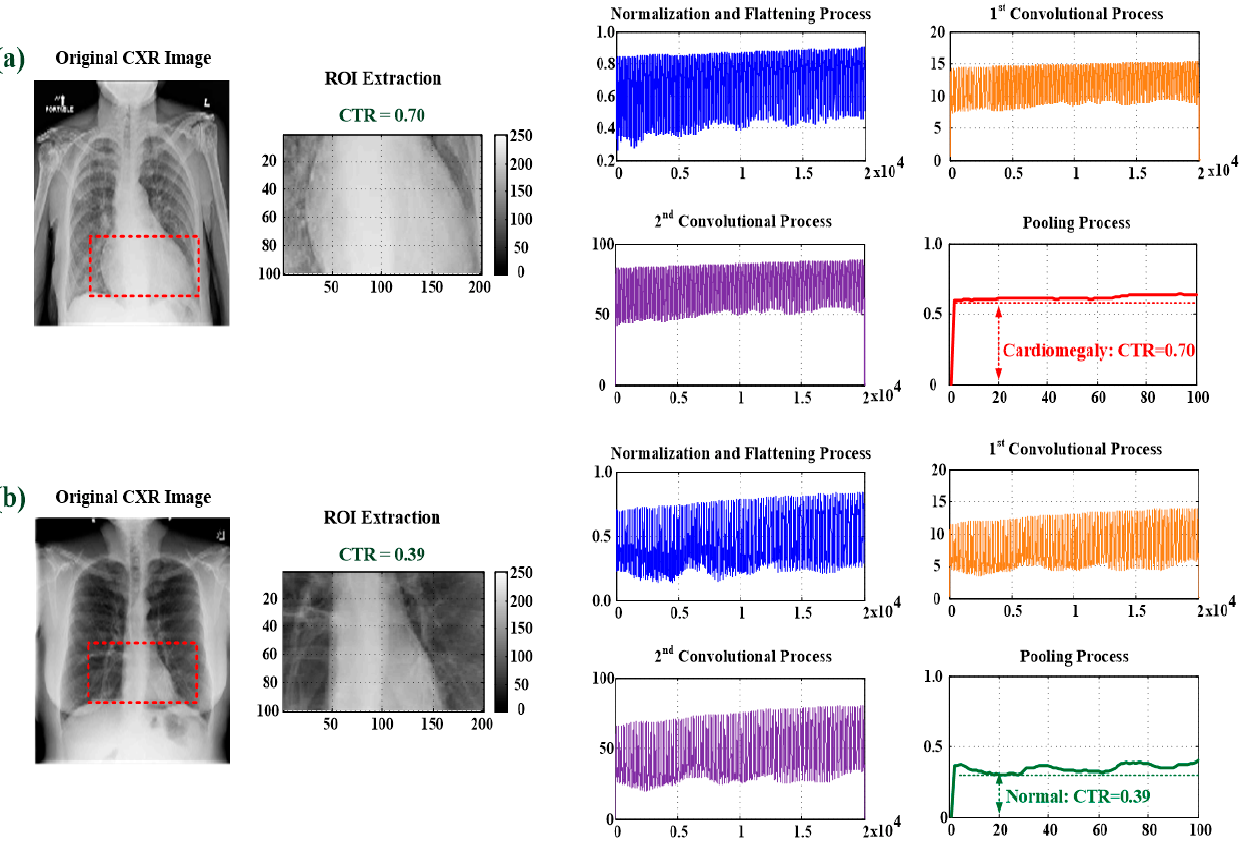
Figure 2. Feature map extraction with ROI extraction, normalization, and flattening; first and second convolutional processes; and pooling process. ( a ) For cardiomegaly, CTR = 0.69; ( b ) for normal condition, CTR = 0.39.